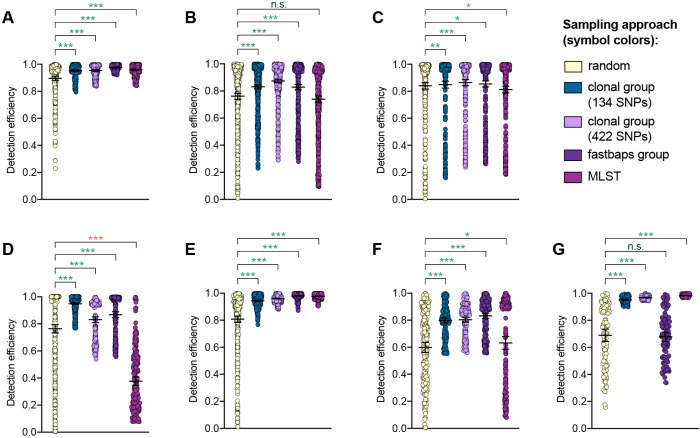
Detection efficiency of clonal group sampling across different similarity thresholds.Scatter dot plots showing the detection efficiency (with lines indicating the mean and 95% confidence intervals from 100 simulations) for resistance variants RplD G70D (A), 23S rRNA C2611T (B), and penA XXXIV (C) in datasets 1–5 and for diagnostic-associated variants 16S rRNA C1209A (D), N. meningitidis-like porA (E), cppB deletion (F), and DR-9A G168A (G) in all datasets in which the variant was present. Note that sampling simulations were not performed for RplD G70D in datasets 1 and 4 or for penA XXXIV in dataset 3 as prevalence of the variants in these datasets was >10%. Dot colors indicate the sampling approach, and asterisks indicate a significant difference (p<0.05 by Mann-Whitney U test) in detection efficiency between the phylogeny-aware approach compared to random sampling (*p<0.05, **p<0.01, ***p<0.001; red asterisks indicate significantly lower detection efficiency of the phylogeny-aware approach compared to random sampling, and green asterisks indicate significantly higher detection efficiency of the phylogeny-aware approach compared to random sampling). n.s., not significant at α = 0.05.